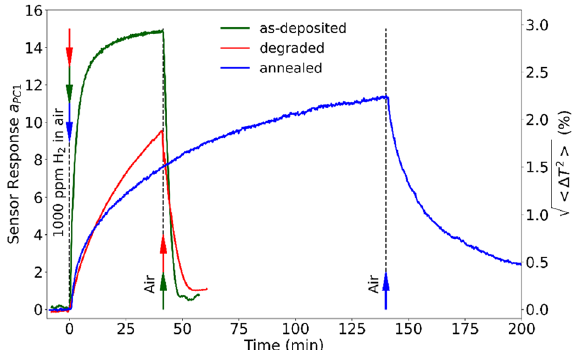
Figure 5. Time-dependent response of the as-deposited (green curve), degraded sensor (red curve) and annealed sensor (blue curve) when exposed to 1000 ppm of hydrogen in air.